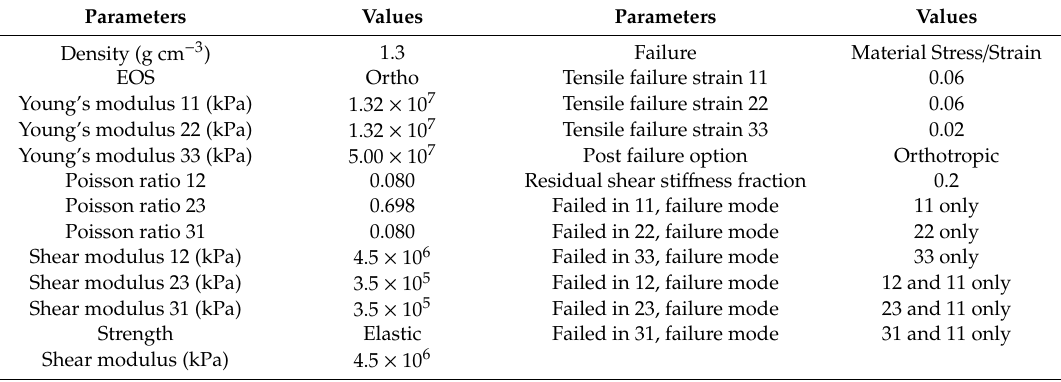
Table 5. Material properties of nanocomposite laminates having 0.25 wt% of MWCNTs.